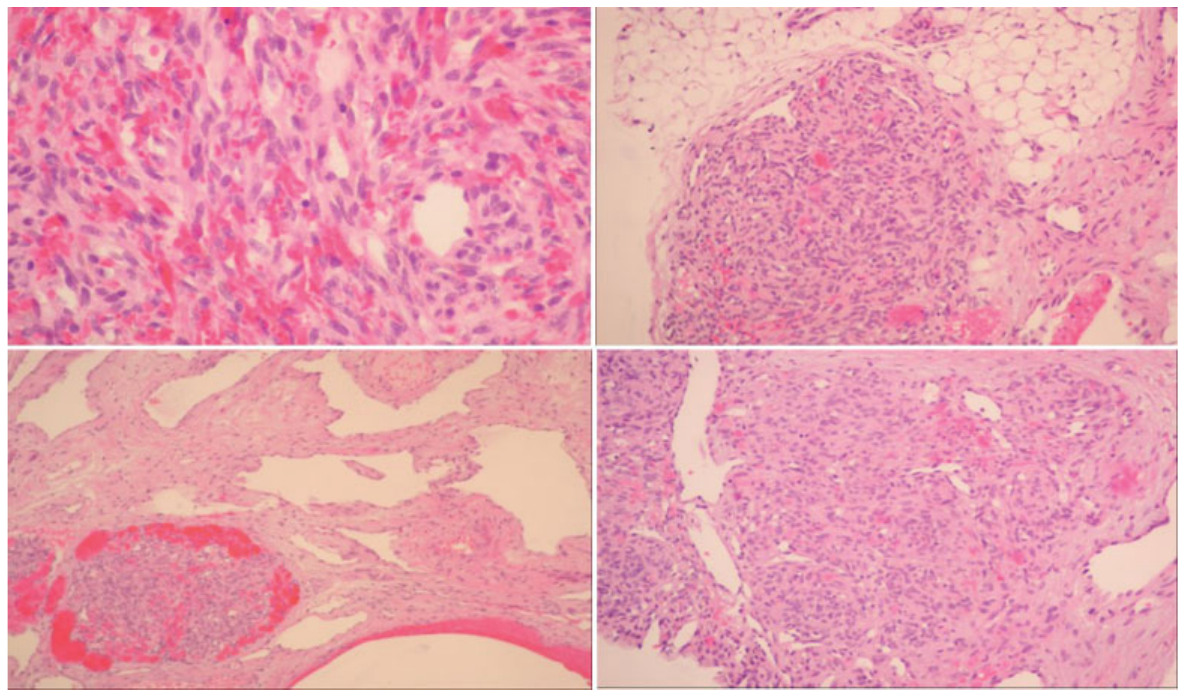
Fig. 2 Pathology fi ndings pancreatic kaposiform hemangioendothelioma. Hematoxylin-eosin staining shows abnormal proliferation of spindle endothelial cells in pancreatic tissue and slit-like lumen